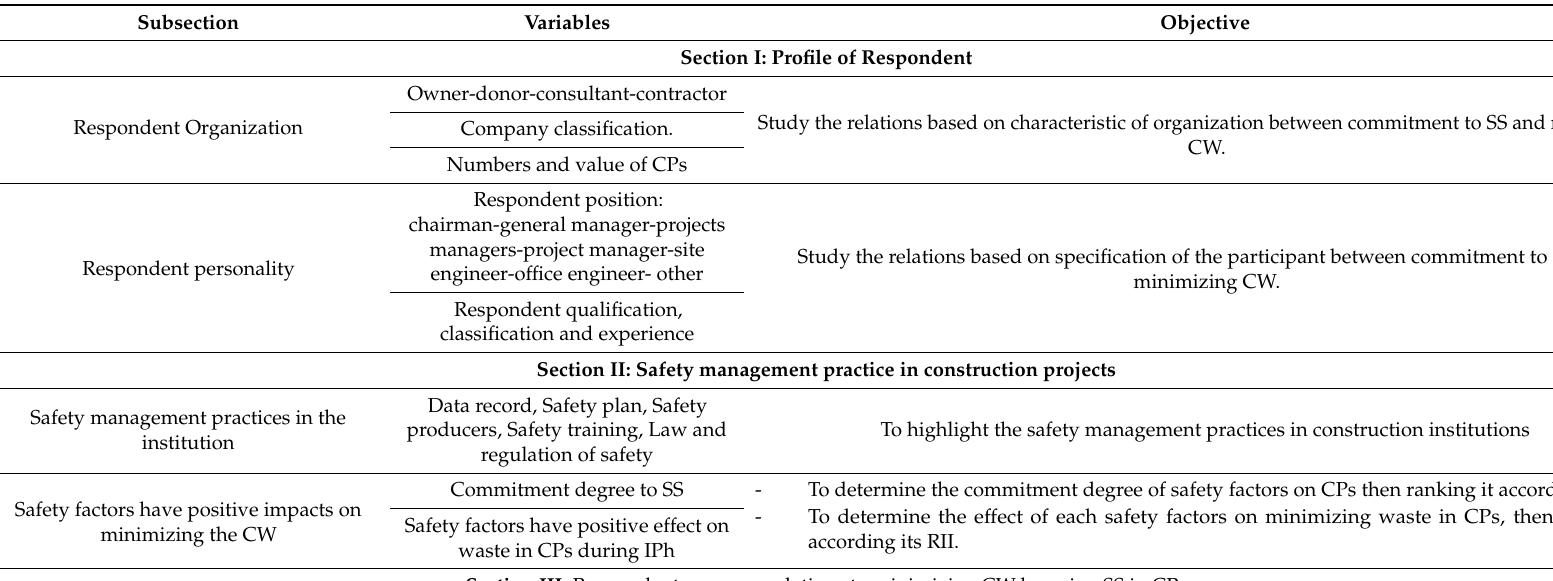
Table 1. Questionnaire